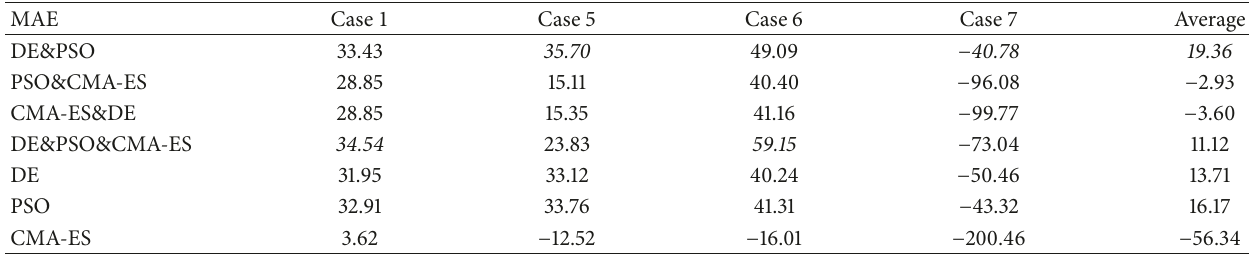
Table 13: Performance improvement with respect to MAE